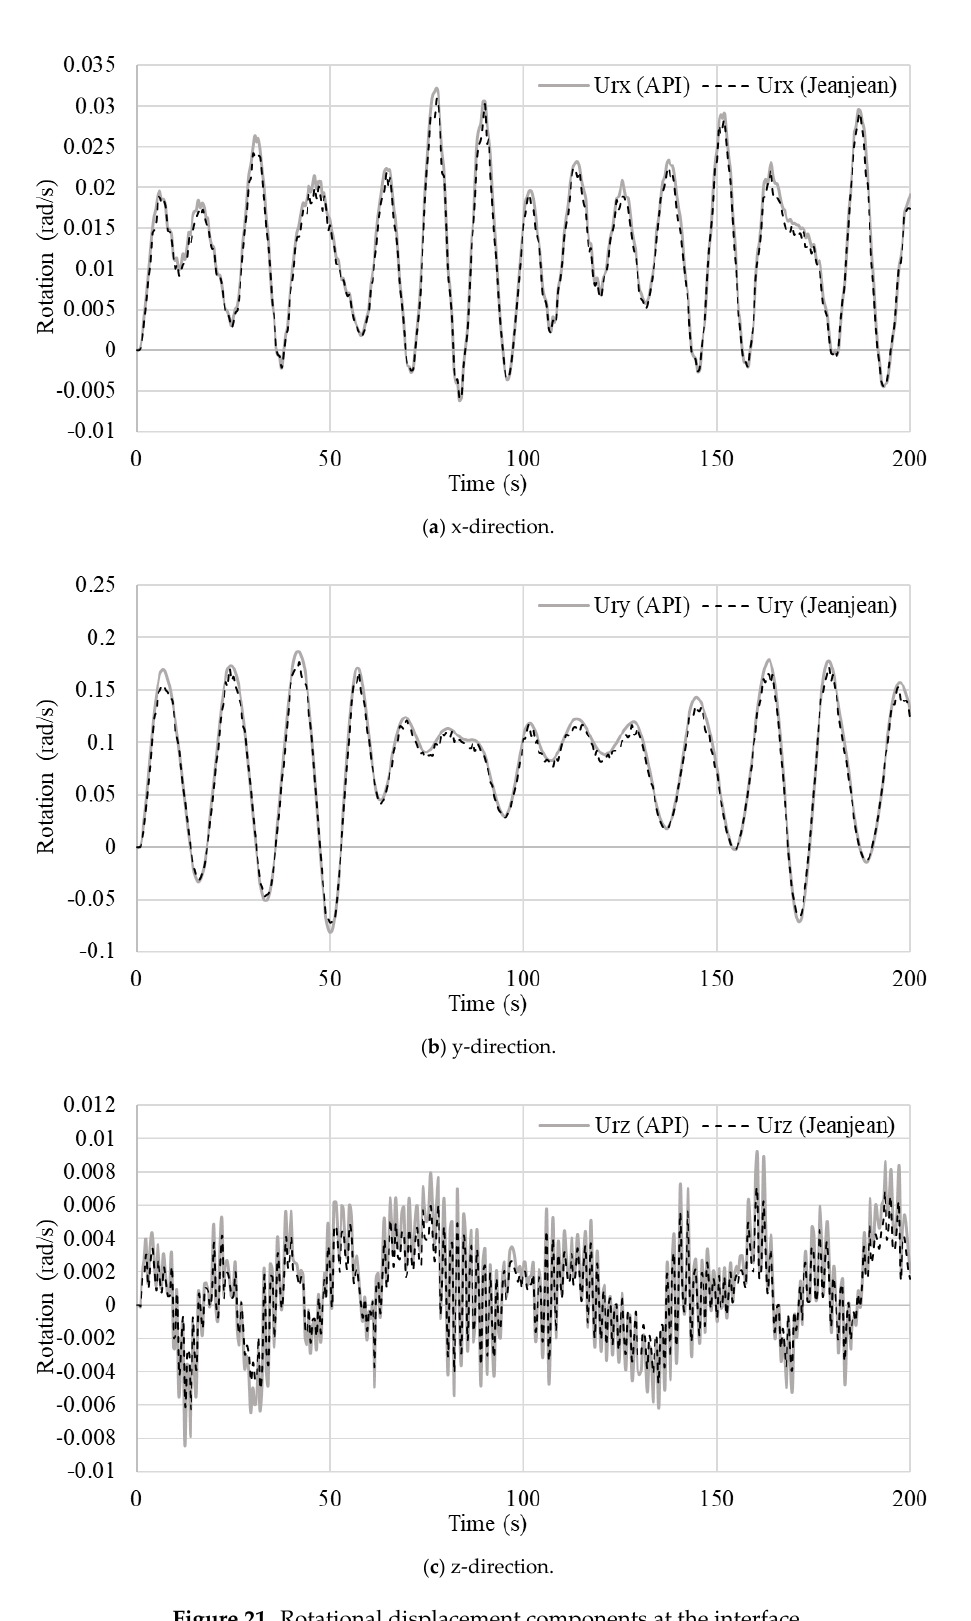
Figure 21. Rotational displacement components at the interface.